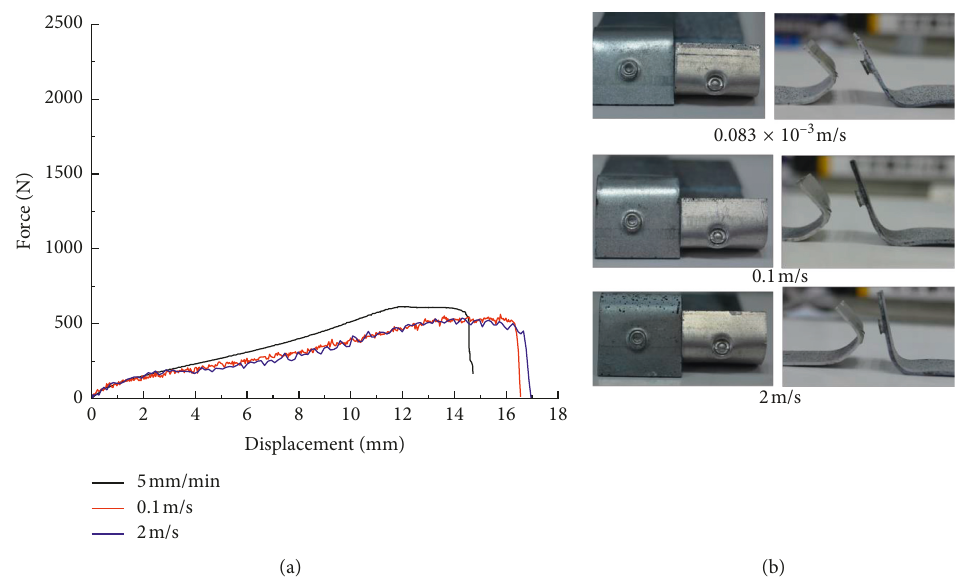
Figure 7: Dynamic coach-peel tests of SPR joints: (a) force-displacement curves and (b) failure modes at three speeds.